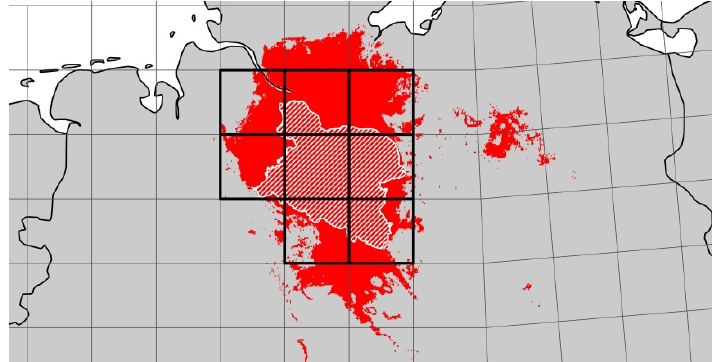
Figure 3. Worldclim grid cells that are currently climatically analogous to Lüneburg Heath (red); EOA grid cells that are currently climatically analogous to Lüneburg Heath and represent the spatial reference for Lüneburg Heath’s species pool (bold